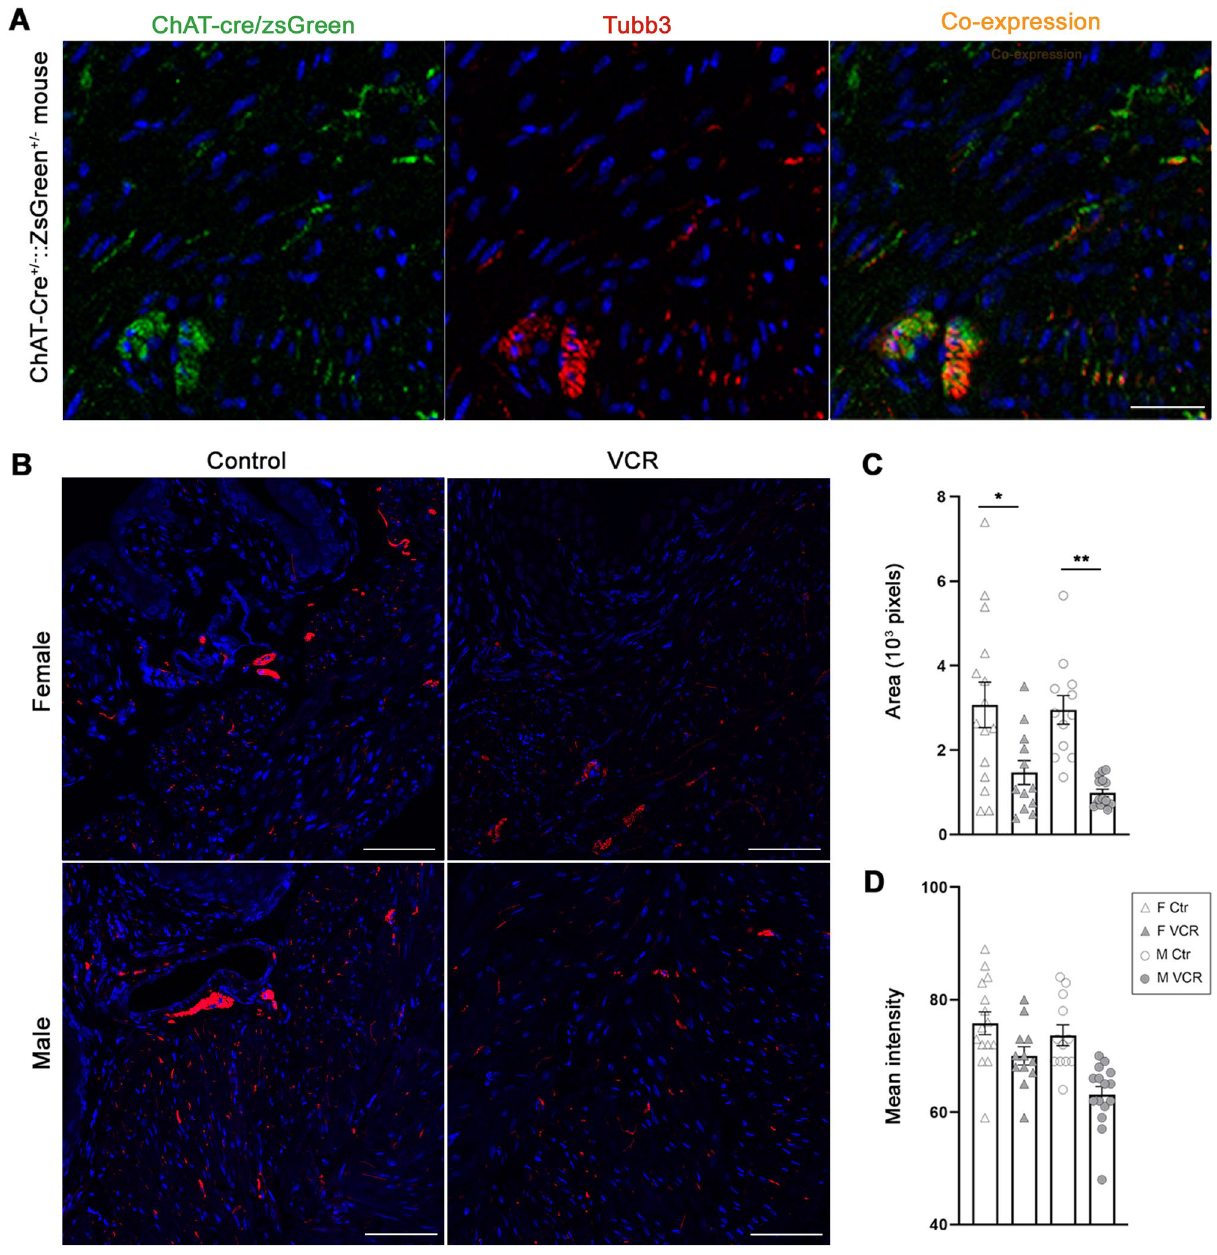
Figure 7. Tubb3 immunofluorescence labeling. ( A ) representative immunofluorescent labeling images with antibody against Tubb3 (red) of the bladder sections from ChAT-Cre +/− :: ZsGreen +/− mice, in which the expression of ZsGreen protein (green) were restricted in ChAT-expression cells. The merged images of ZsGreen and Tubb3 IR (right), shows Tubb3 IR in the Zs-Green positive cells in cluster forms [N = 3] ( B ), representative images of Tubb3 IR (red) in the bladders from female (upper) and male (lower) from the control (left) and VCR (right) groups. Cell nuclei were stained with DAPI (blue) [N = 4–5 per group per sex]. Scale bars = 20 µm ( A ) and 250 µm ( B ). The area ( C ) and mean intensity ( D ) measurements for Tubb3-IR in the bladder sections. *p < 0.05, **p < 0.005. Figures were prepared using Adobe Photoshop CS6 and GraphPad Prism 8.4.3 (https:// www. graph pad. com/ scien tific- softw are/